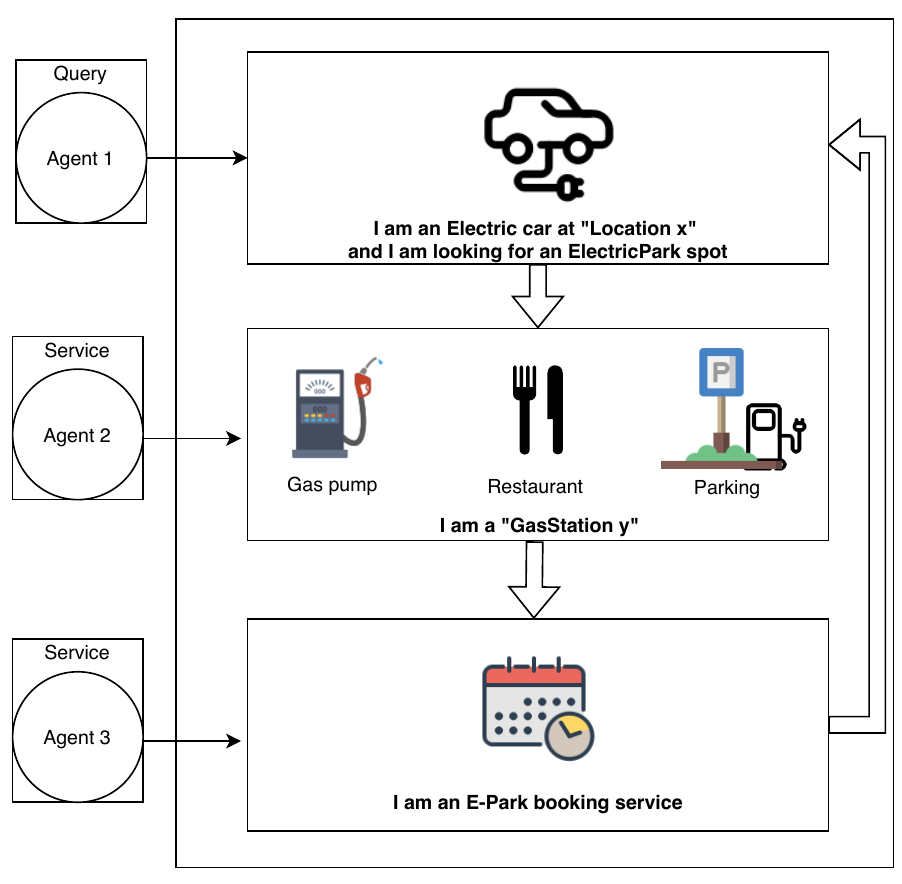
Figure 3. Scenario of a spatial service providing identification and booking of an electric car parking spot in a gas